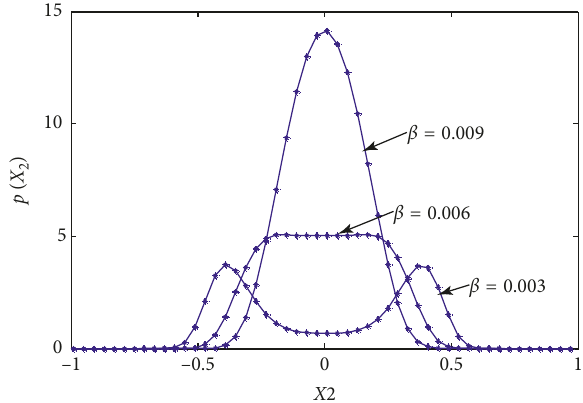
Figure 6: Section graphs of probability density function s when x